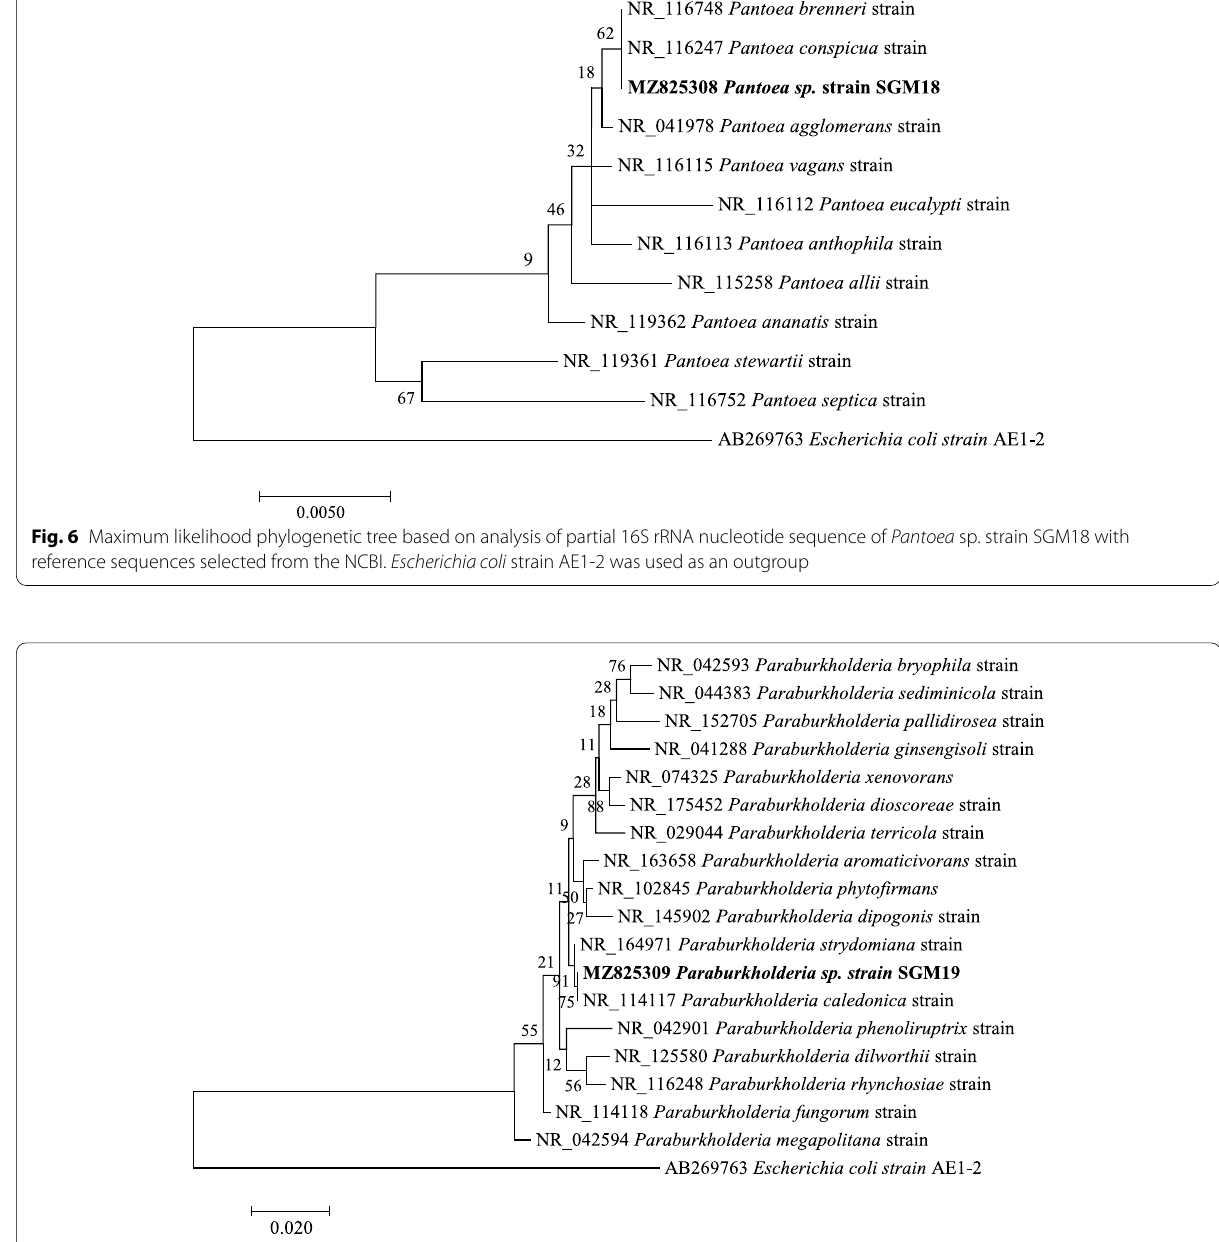
Fig. 7 Maximum likelihood phylogenetic tree based on analysis of partial 16S rRNA nucleotide sequence of Paraburkholderia sp. strain SGM19 with reference sequences selected from the NCBI . Escherichia coli strain AE1-2 was used as an